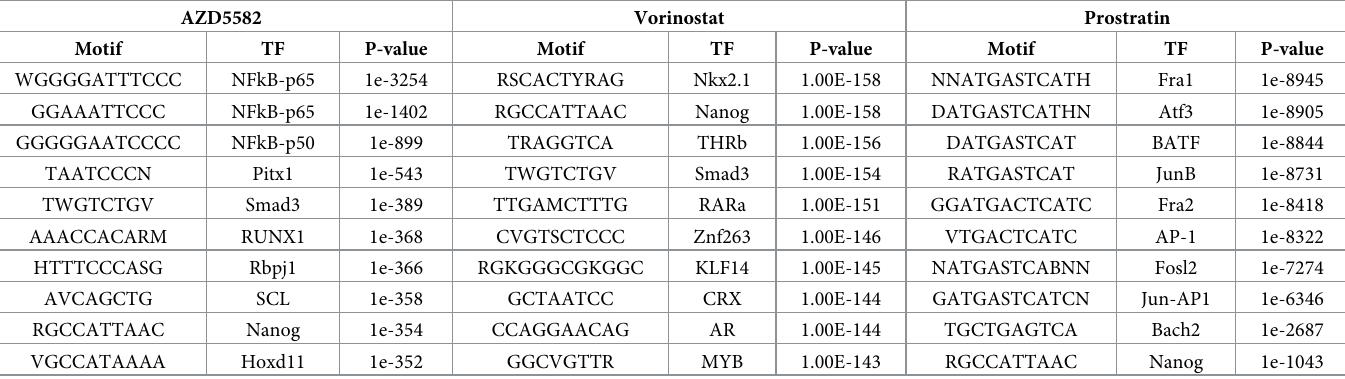
Table 2. TF motifs with increased enrichment after LRA stimulation.